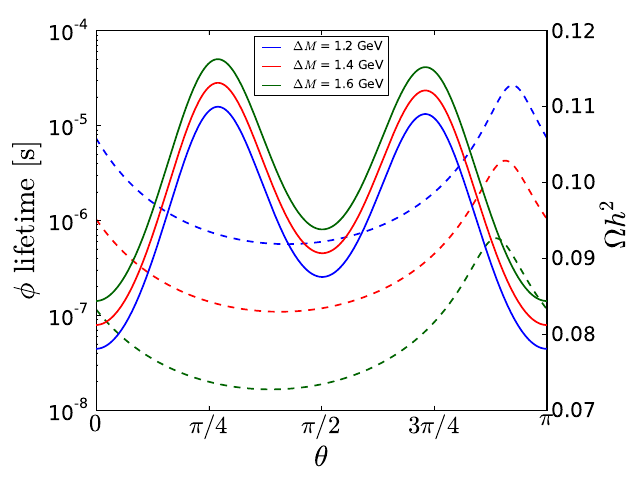
2 (solid) as functions of the Figure 9 . The lifetime of (cid:30) (cid:6) (dashed) and the DM relic density (cid:10) h L-R mixing parameter (cid:18) . The DM mass is (cid:12)xed at 300 GeV and (cid:1) M is varied as 1.2 (blue), 1.4 (red) and 1.6 (green)